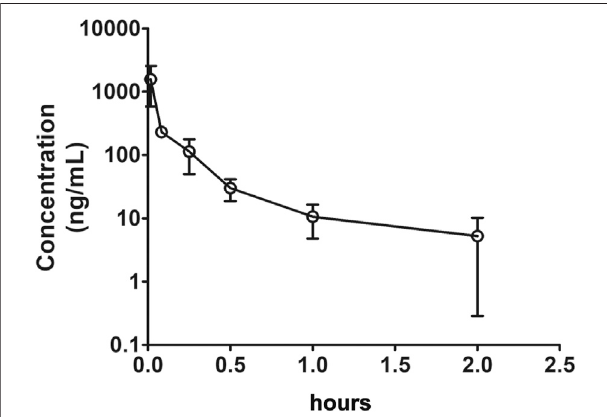
TABLE 3 | Recovery of Indo5 in rat plasma and tissues.